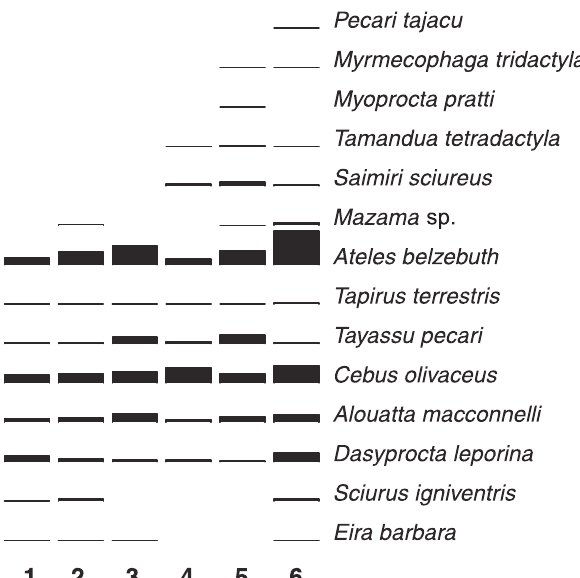
Figure 1. Direct ordination of species abundance (number of sightings) distributed between the six transects sampled. The height of the bars represents the number of sightings for each species in a particular transect, ranging from 0 (none bar) to 36. The numbers below the bars represent transect